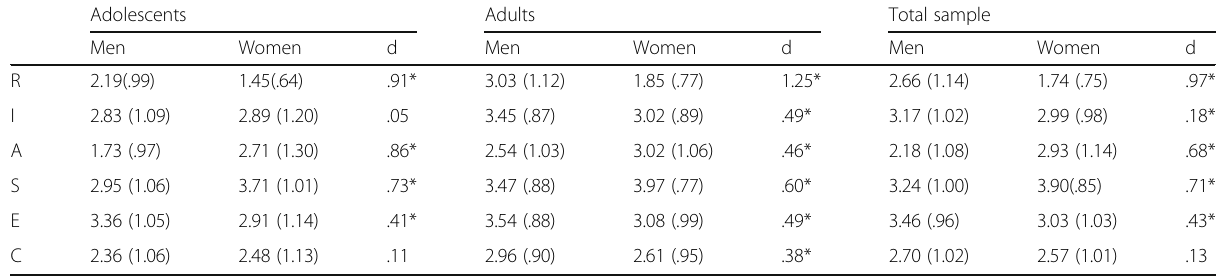
Table 3 Between-sex mean comparisons (standard deviations within parentheses) for the disaggregated and the aggregated sample Adolescents Adults Total sample